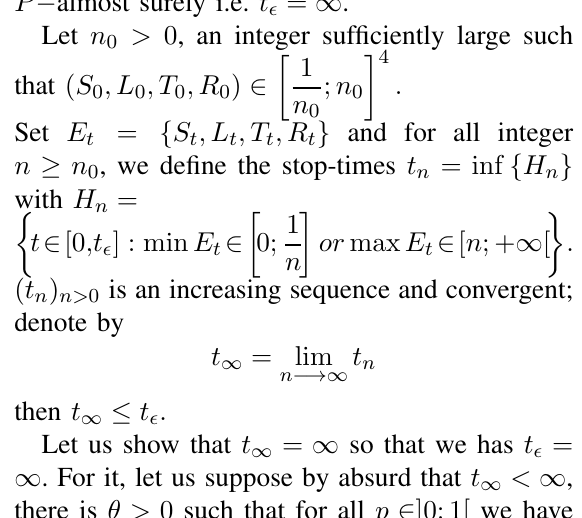
Fig. 7. Trajectory without and with control of TB active infected individuals T. With β T = 0 . 08 for t. 3 and β T = 0 . 8 for t. 4